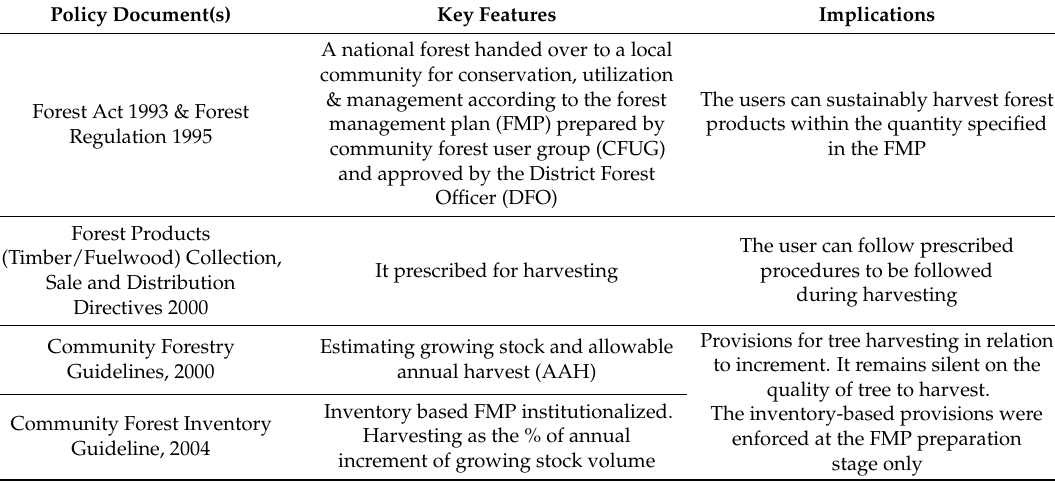
Table 1. Key features and implications for harvesting found in major regulatory policy documents in